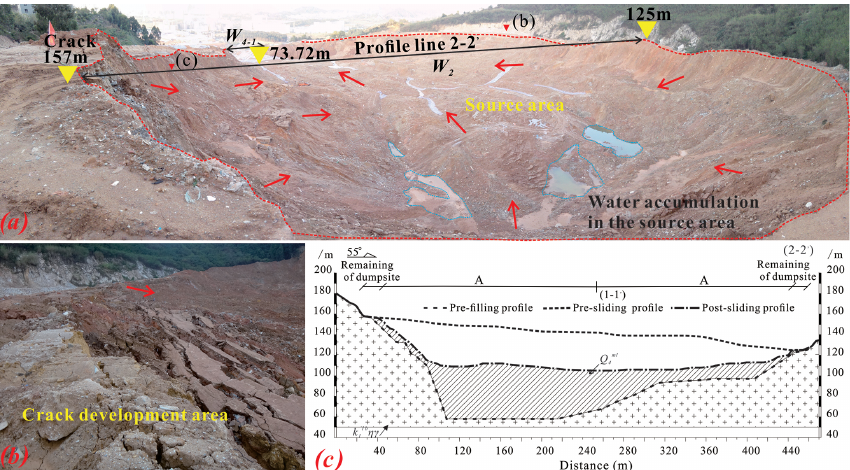
Figure 12. (a) An overview of the source area (image taken at the flowslide crown facing north). A large opening ( W 4 − 1 ) formed due to the failure of the retaining slope (the exit of the original quarry pit), which provided passage for the flowslide and permitted rapid release of kinematic energy. (b) Surface cracks developed due to unloading near the crest and the flanks of the flowslide. (c) The geological cross section (profile line 2-2’) of the source area.